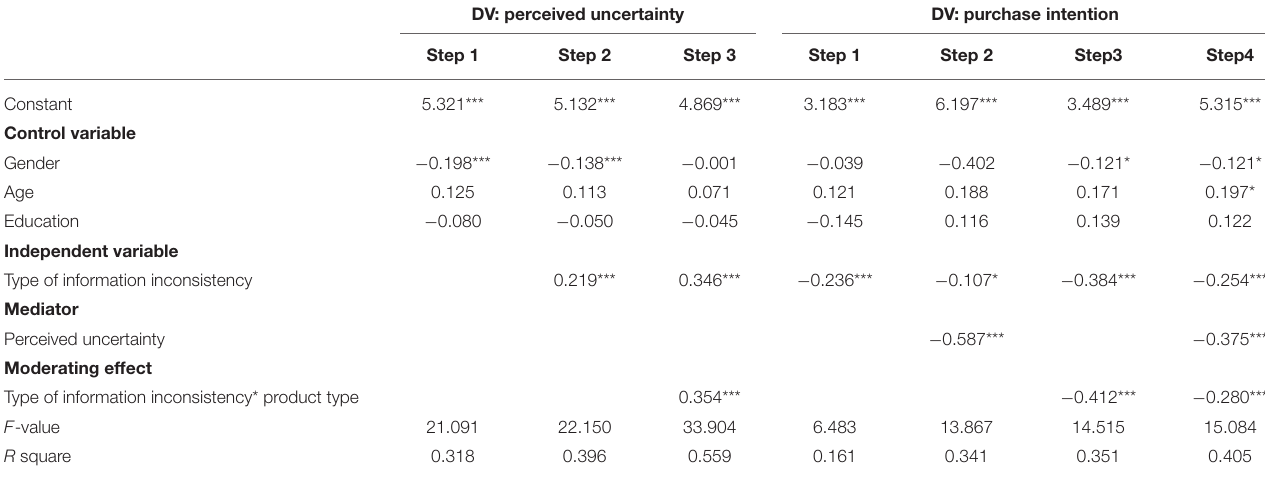
TABLE 2 | Results of hierarchical regression.